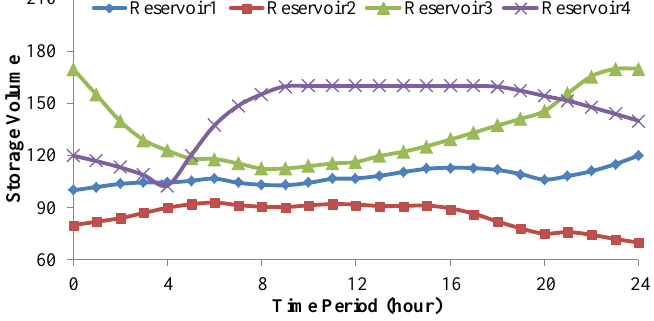
Figure 10. The water storage processes of Scheme 15 by PMOGA for Case 2.